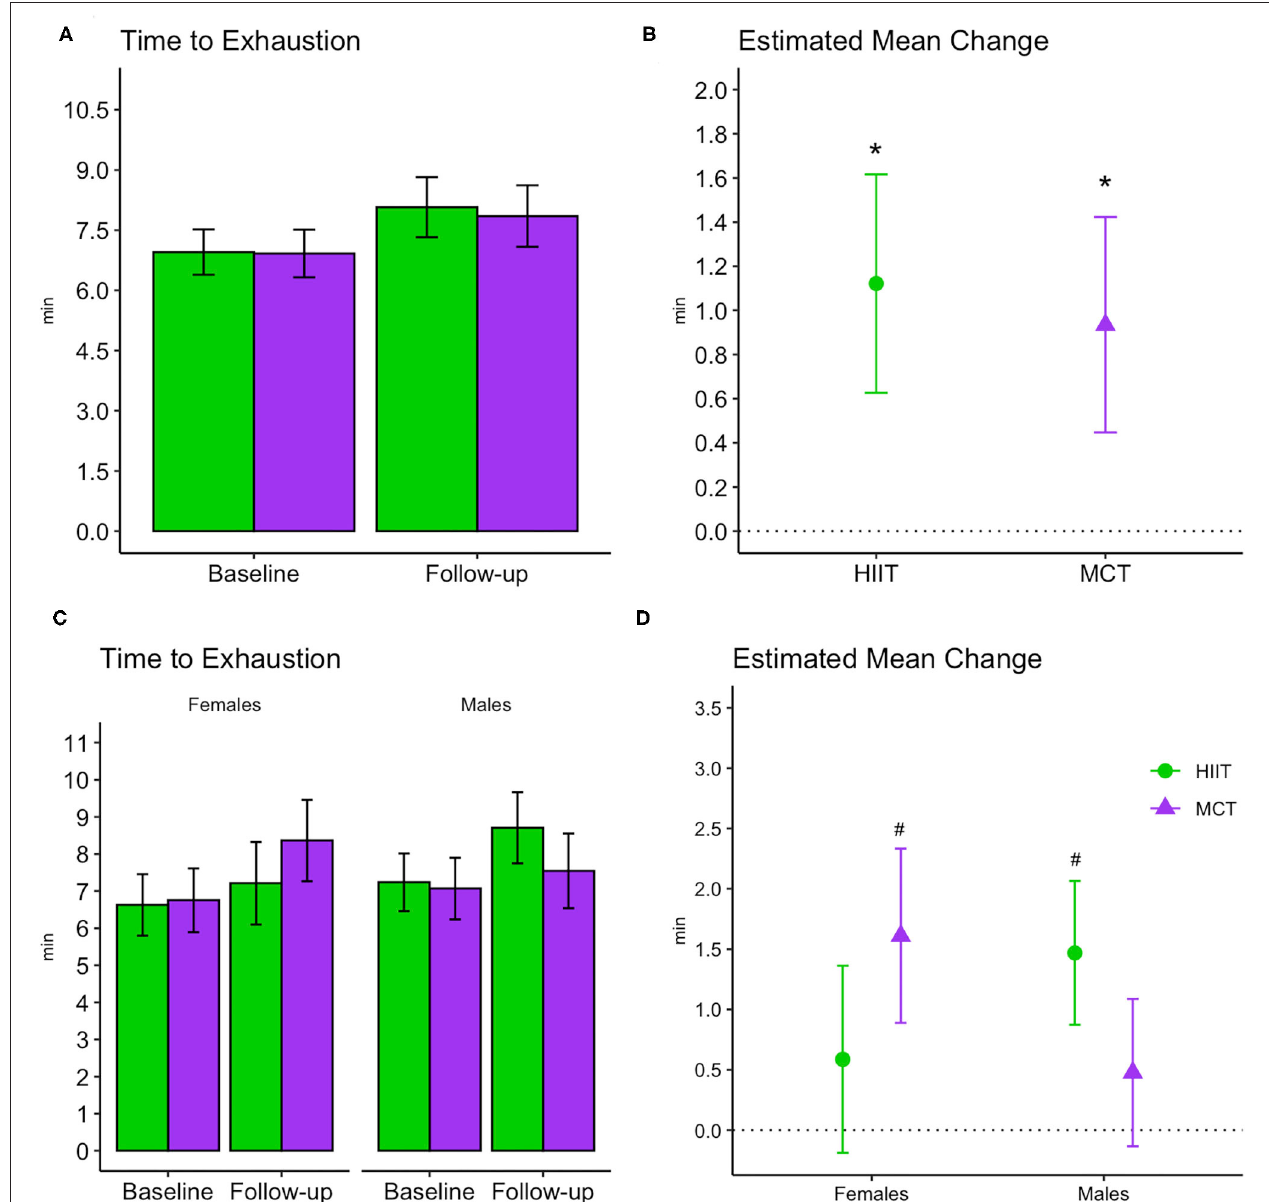
FIGURE 7 | Baseline and follow-up means for time to exhaustion during exercise stress tests (bar plots, group mean and 95% CI) and estimated mean change from baseline to 6 months (scatterplots, estimated mean change and 95% CI). (A,B) Display changes for the entire sample, while (C,D) display changes stratified by males and females. *, significant changes over time; #, significant subgroup changes over time at adjusted significance threshold ( p ≤ 0.005), with improvements in females within the MCT group [estimated mean change (95% CI): 1.61min (0.9 to 2.33), p = 0.00003] and males within the HIIT group [1.47min, (0.87 to 2.07), p = 0.000006]. See Supplementary Table 3 for further details. HIIT, high-intensity interval training; MCT, moderate-intensity continuous